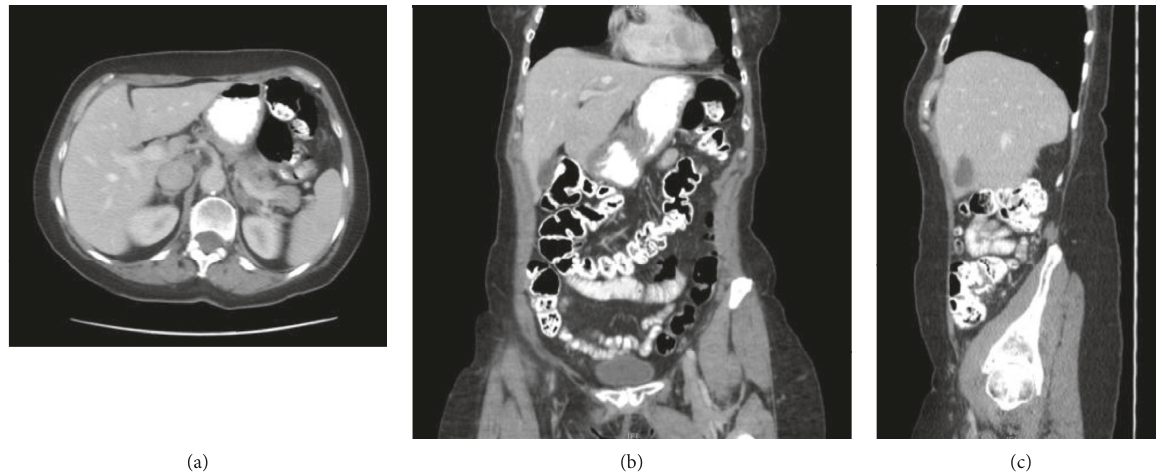
Figure 1: (a) Axial, (b) coronal, and (c) sagittal images from the patient’s 2015 CT abdomen and pelvis showing no colon anterior to the liver.